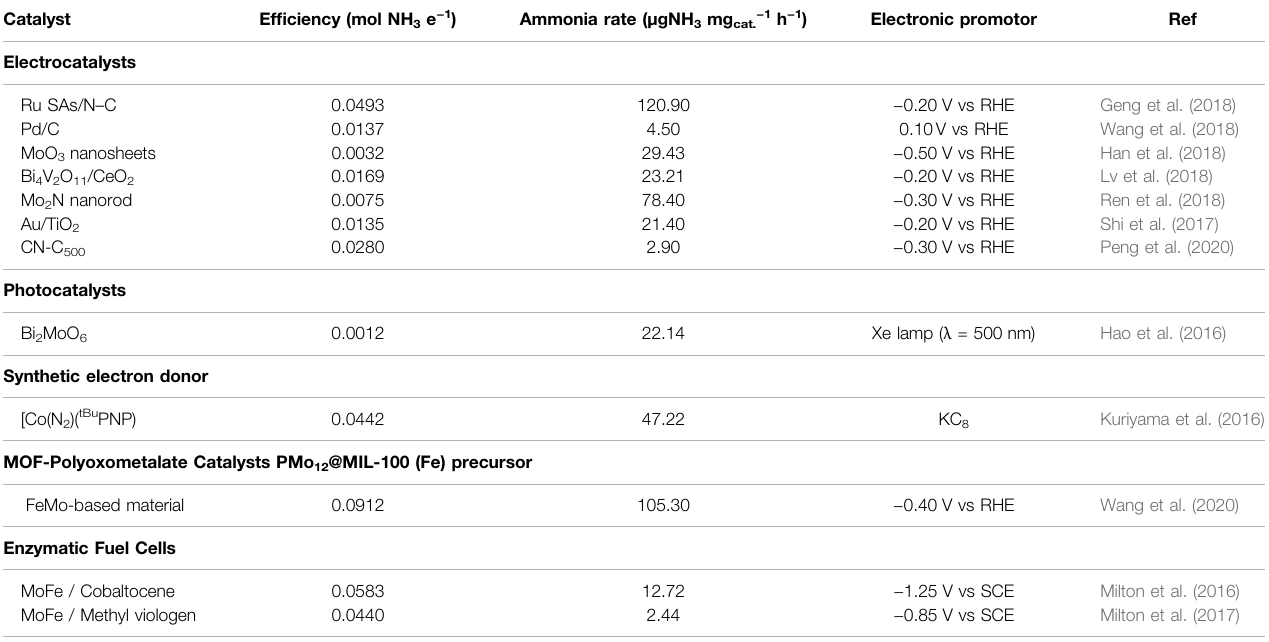
TABLE 1 | Ef fi ciencies of selected novel catalysts for N 2 fi xation under ambient temperatures and pressures. RHE (cid:1) Reversible Hydrogen Electrode / SCE (cid:1) Standard Calomel Electrode.